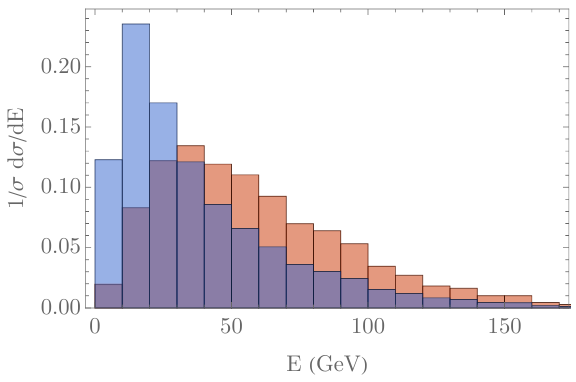
Figure 4 . Primary production modes and representative Feynman diagrams for each mode for the µ - τ -flavored scalar φ at beam dumps.